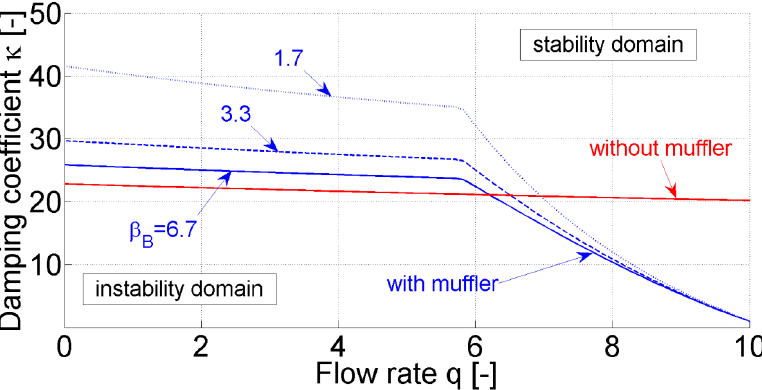
Figure 4. Stability boundaries for various stiffness β B of the cavity B [13].